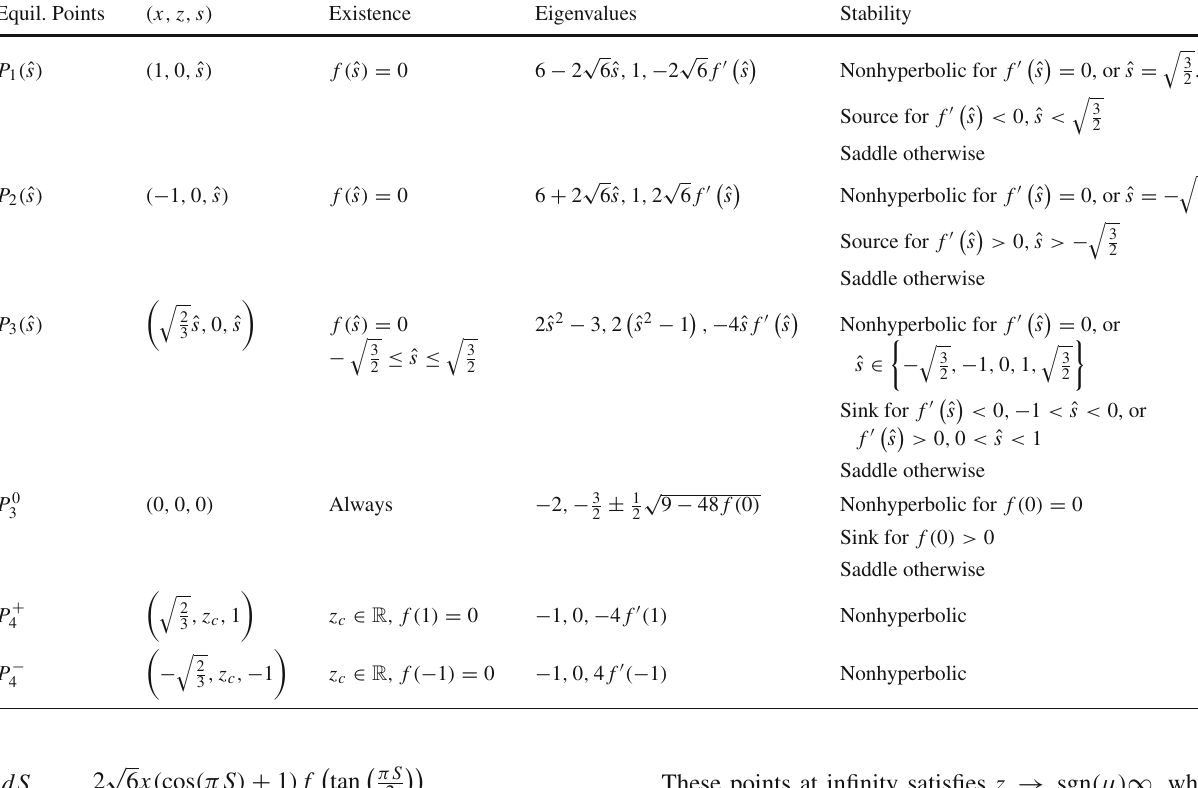
Table 1 Case 1: Equilibrium points at the finite region of the system (21), (22), (23) Equil. Points ( x , z , s ) Existence